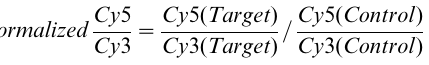
Figure S3 Comparison of signal from matched or partially mismatched reporter strands on DTM. The signal from the array spot with both tags complementary to the single stranded ligation product is significantly greater than for array features where only one of the tags is complementary.